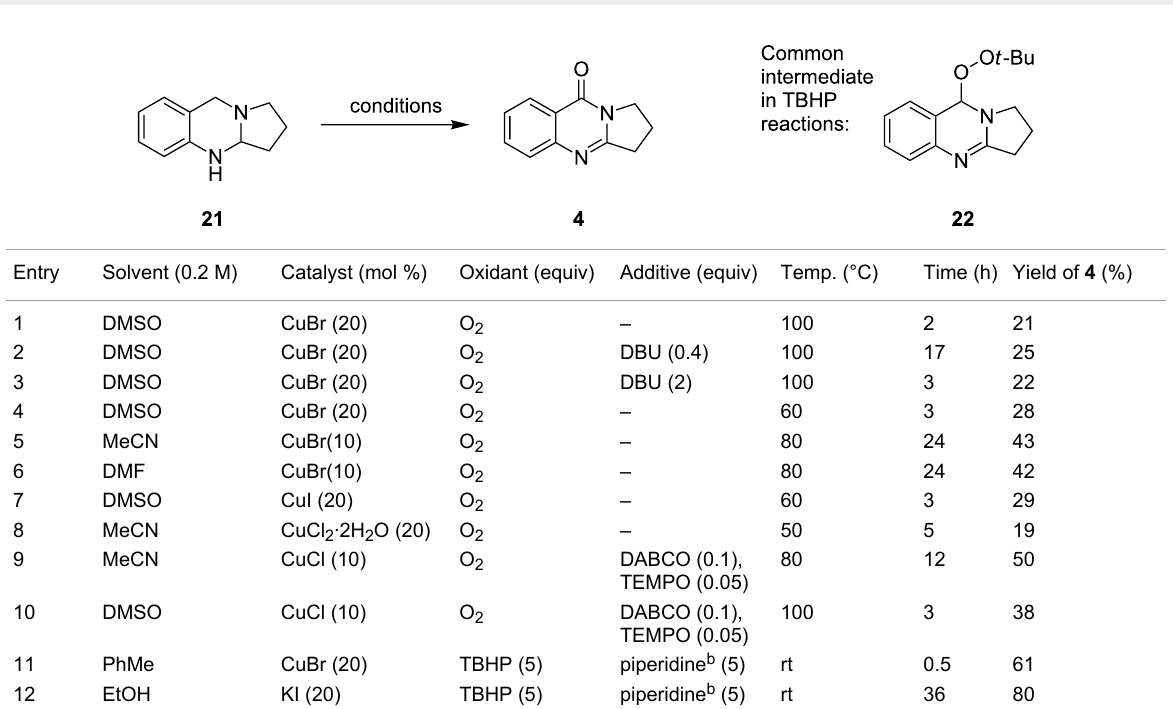
Table 3: Optimization of conditions for deoxyvasicinone ( 4 ) formation.